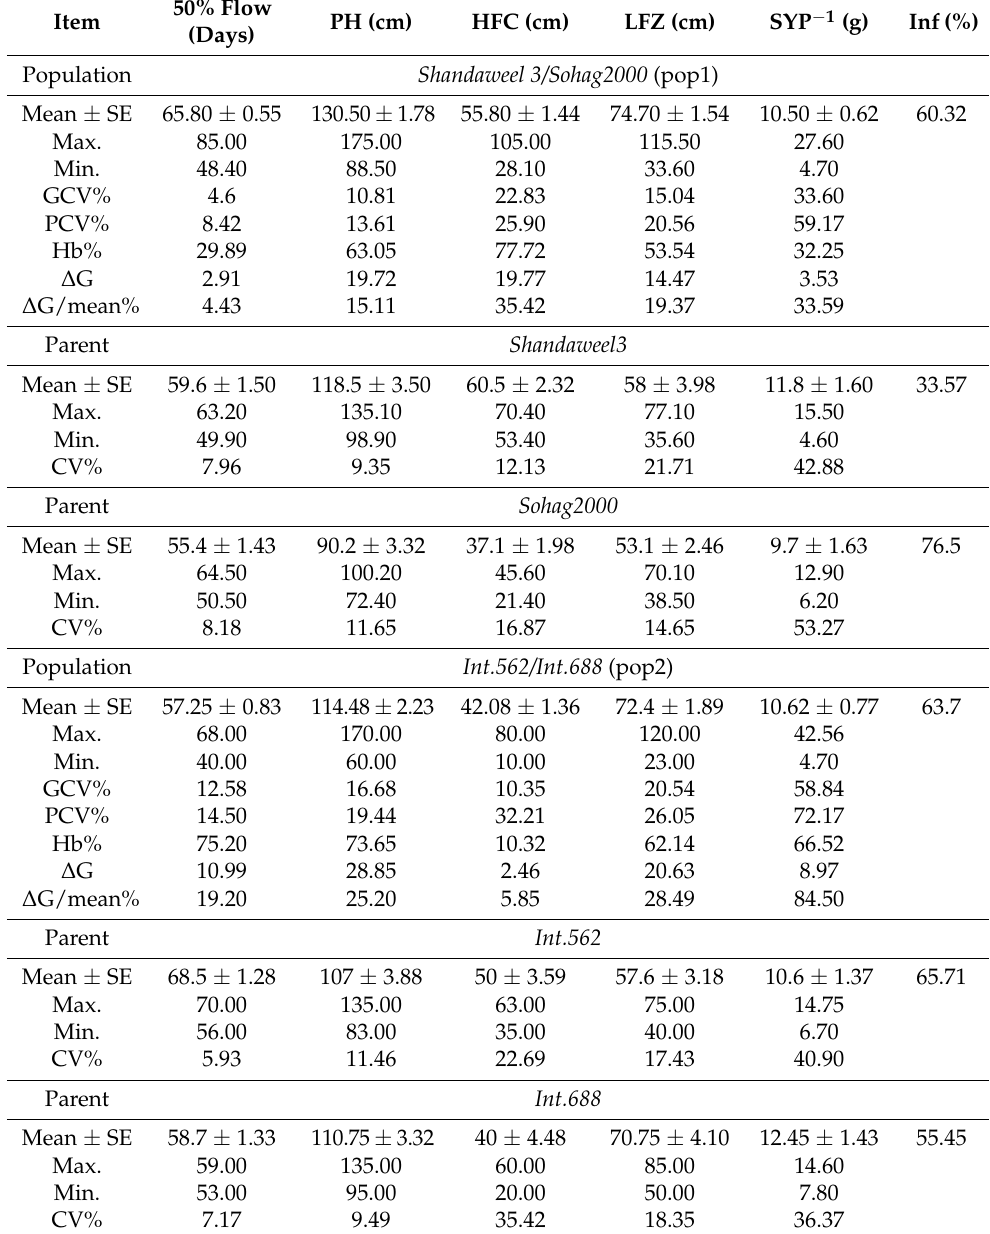
Table 1. Statistical analysis summary of the populations, including means of the studied traits, genotypic (GCV) and phenotypic (PCV) coefficients of variation, heritability in the broad sense (Hb%), and expected genetic advance ( ∆ G) of the two bases populations in the F 2 - generation evaluated under artificial infection of F. oxysporum